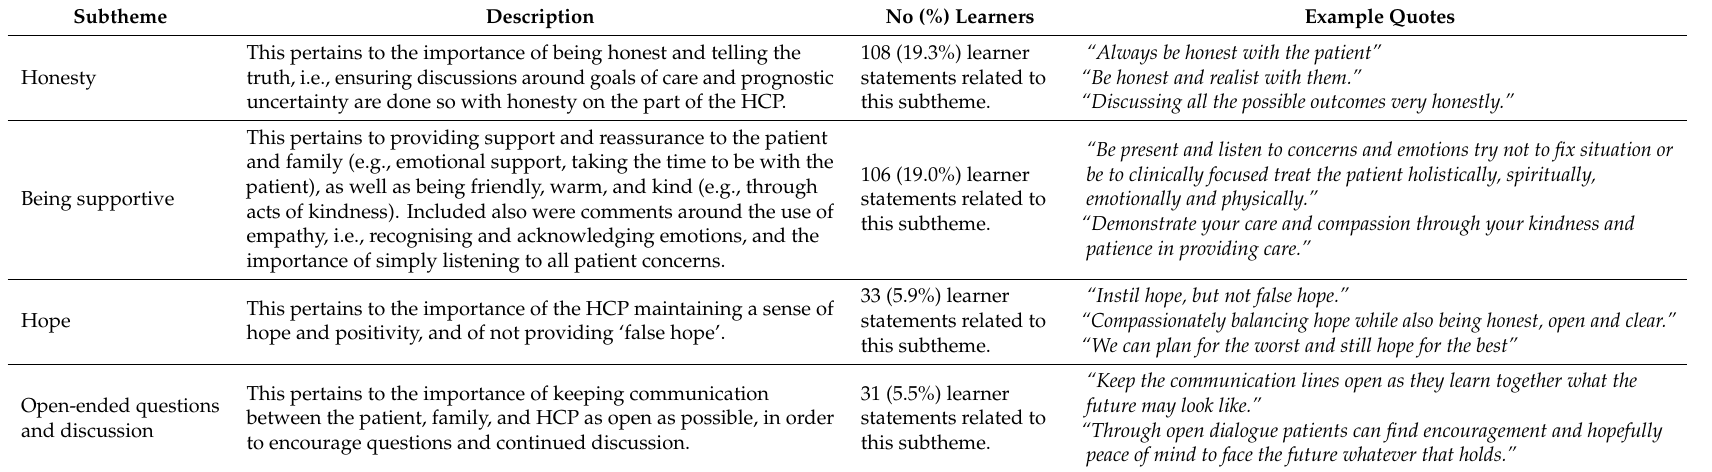
Table 3. Valued communication skills subtheme